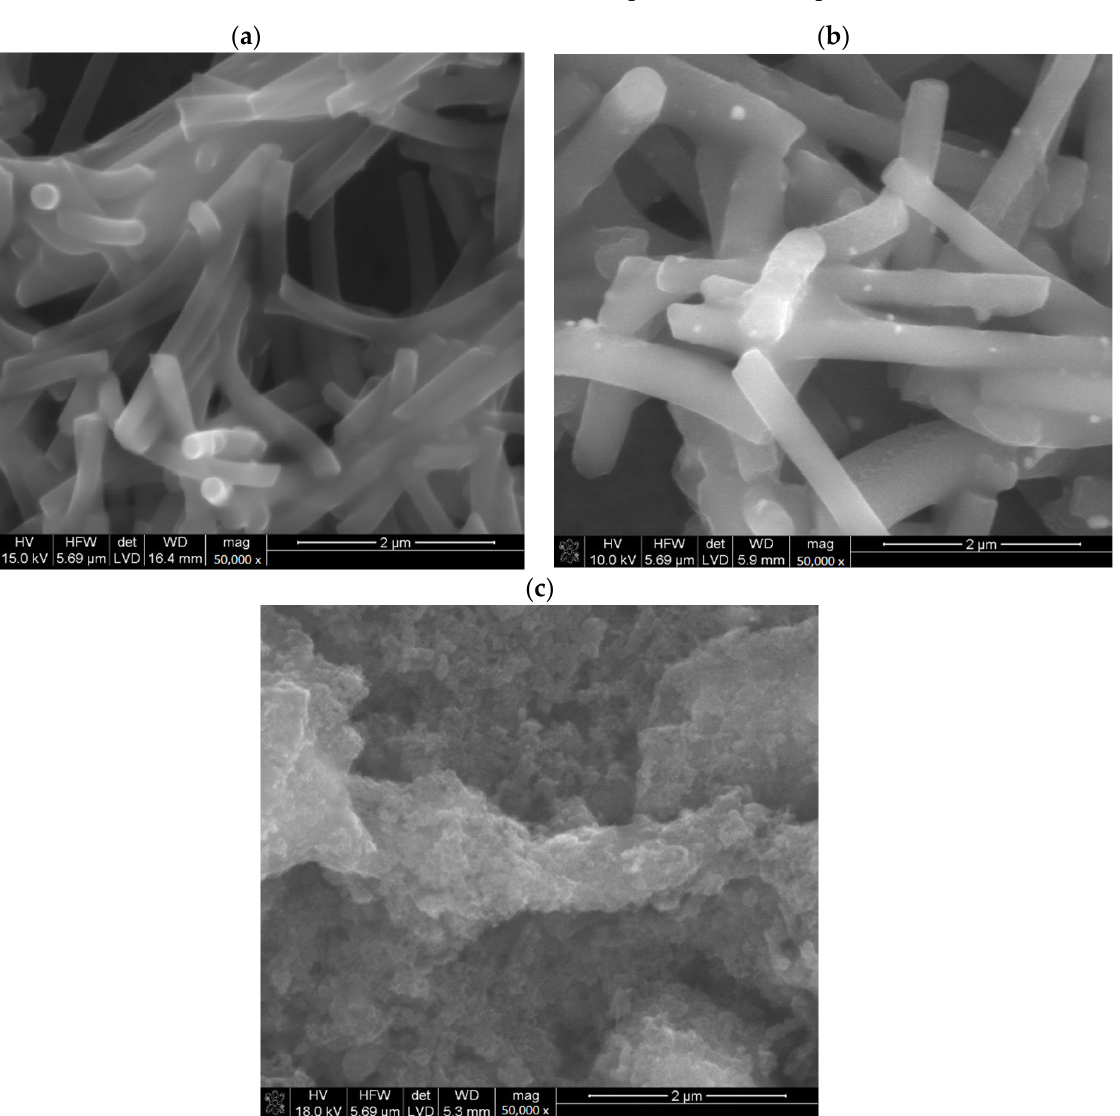
Figure 1. SEM miscroscans of investigated materials eCNF+POT ( a ), eCNF-Co+POT ( b ), eCNF/CNT-NiCo + POT ( c ).